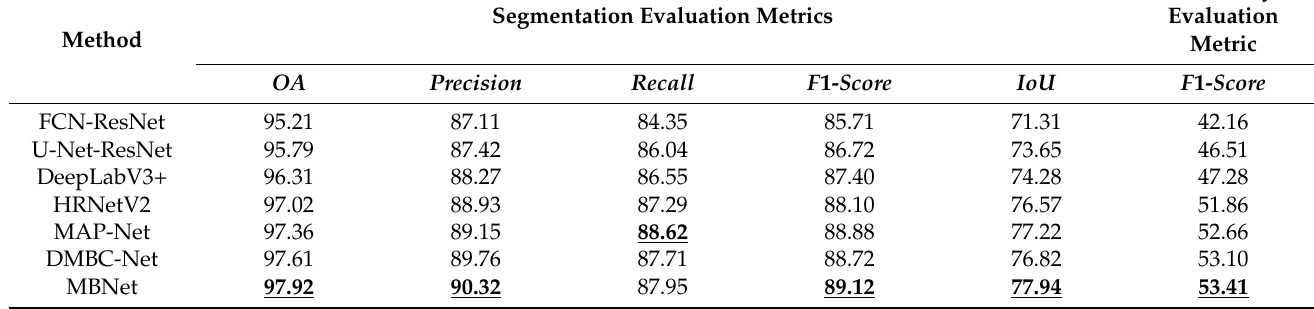
landforms in the test set, where values in bold and underlined are the